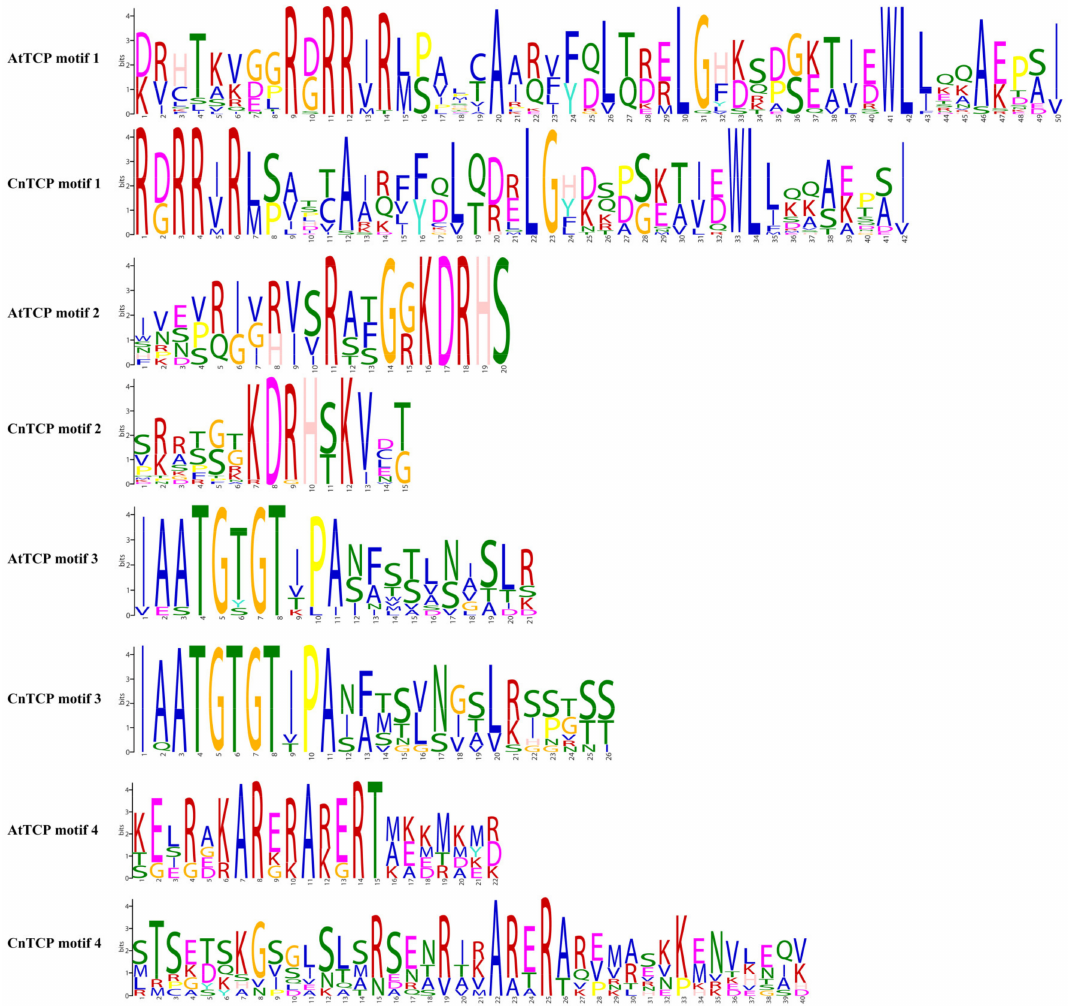
Figure 4. Sequence LOGOs for each motif of TCP domains using the MEME algorithm. The motif consensus of the predicted domain in CnTCP and AtTCP proteins. The height of a single letter in the stack indicates the probability of that letter in that position multiplied by the total information content of the